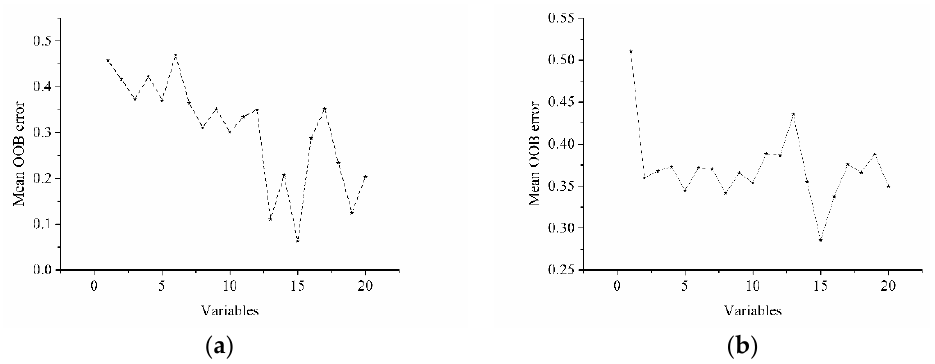
Figure 6. Mean OOB error values of RF models using different wavelength variables: ( a ) intact sausages; ( b ) sliced sausages.